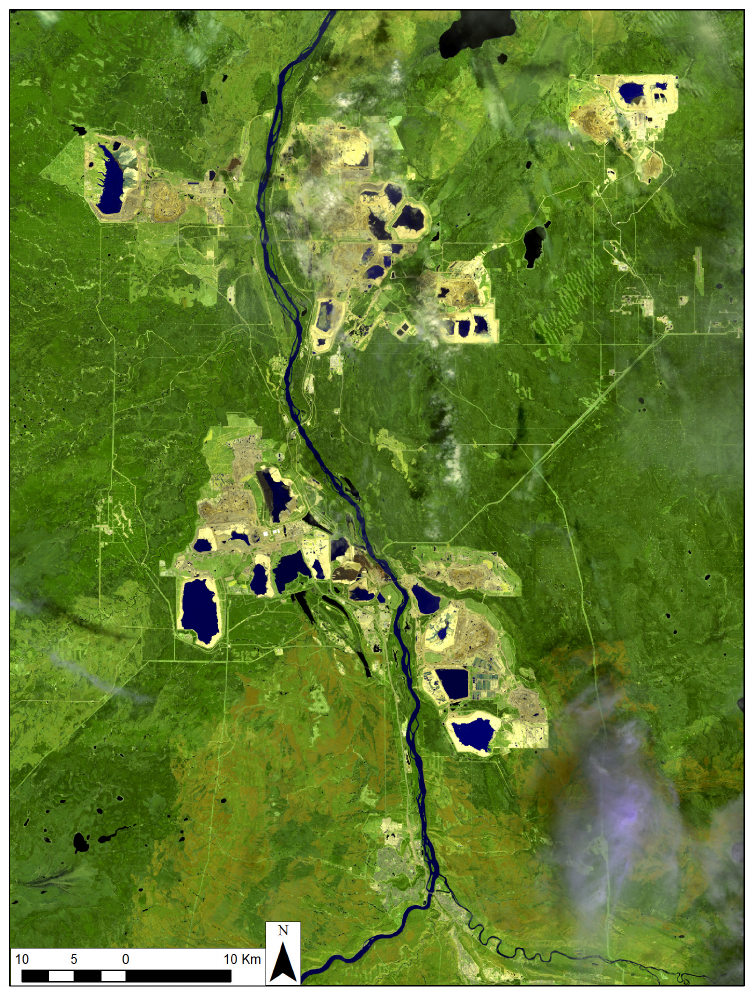
Figure 2. The Athabasca Oil Sands area north of Fort McMurray in 2017. Since the mid-1990s the original Syncrude and Suncor mines have expanded. Those expansions were joined by six other mining projects: Muskeg River, Jackpine, Aurora North, Horizon, Kearl and Fort Hills. This satellite imagery also shows the footprints of the Firebag, MacKay River, Joslyn Creek and Sunrise in-situ projects. Map: © P.